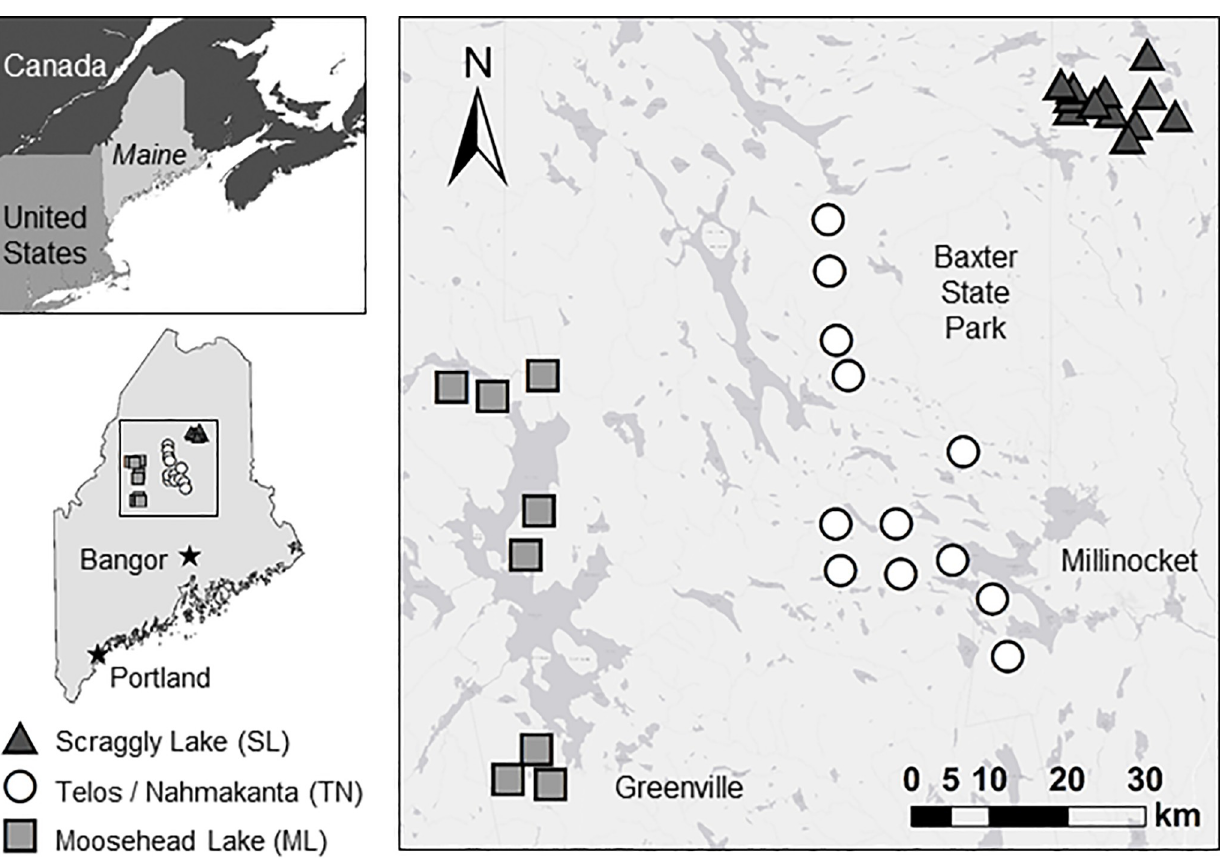
Fig 1. Three study areas surveyed with multiple camera traps in Maine, USA. 12 sites each composed of five camera traps were deployed in the Scraggly Lake (SL) area during January 2017, 12 sites in the Telos Road/Nahmakanta Public Reserve Lands (TN) from February to March 2017, and 8 sites in the Moosehead Lake (ML) area from late February to March